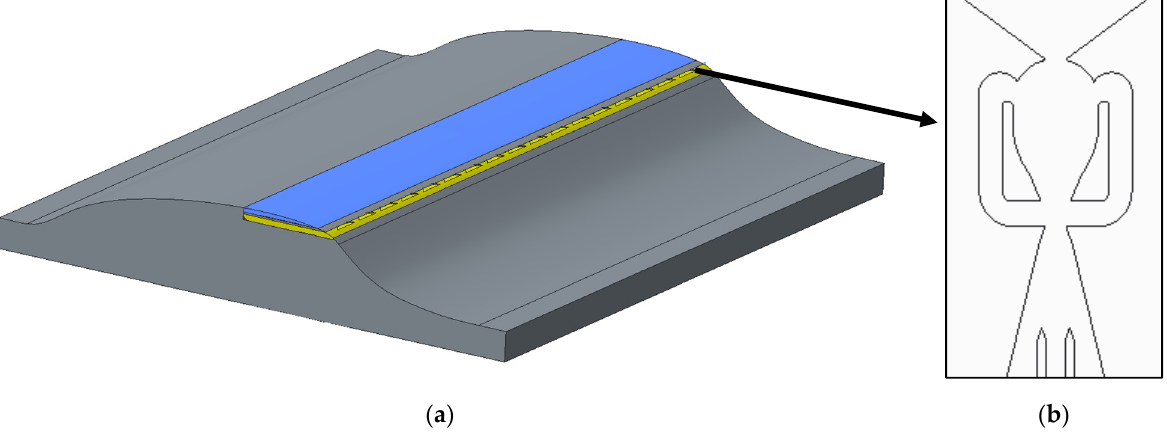
Figure 1. ( a ) CAD rendering of the hump model; ( b ) description of the fluidic oscillators used in this study.